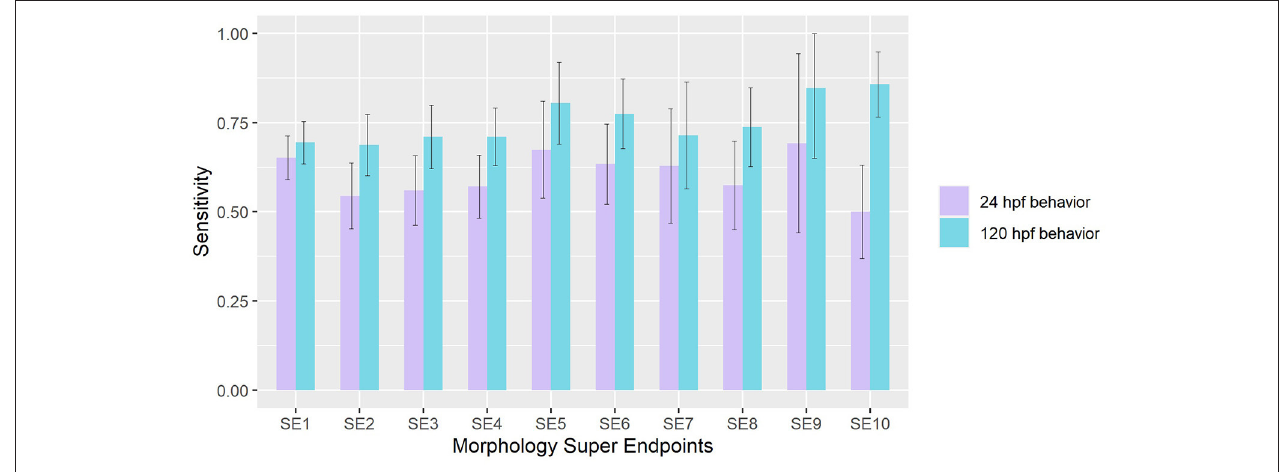
FIGURE 2 | Sensitivity of 24 hpf and 120 hpf behavior in detecting chemicals that affect each morphological super endpoint. Error bars represent 95% confidence intervals.